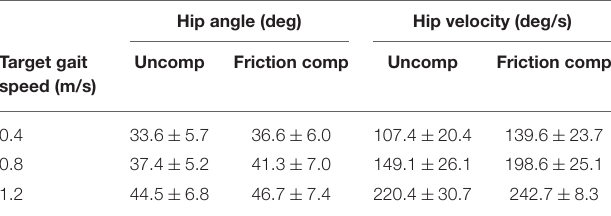
TABLE 3 | Average peak hip angles and velocities attained by subjects per condition over each gait speed.